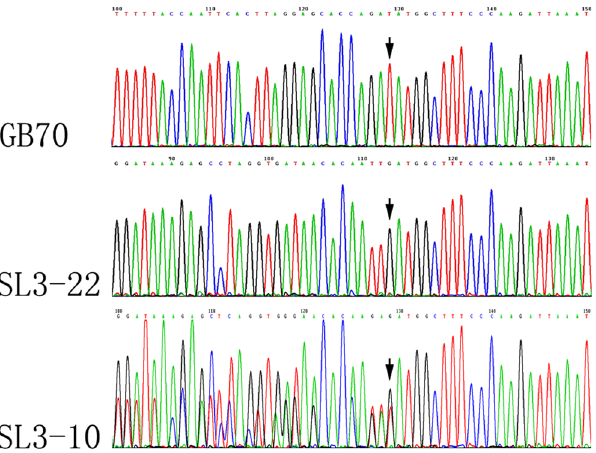
Figure 3. Homozygous and heterozygous COX1 sequencing chromatographs of three representative samples. Strains GB70 and SL3-22 represent two types of homogeneous COX1 sequence. Strain SZ3-10 represents the heterozygous COX1 sequence type containing signatures of a mixture of the above two type of COX1 sequences. Black arrows showed the site differences among the three strains began.